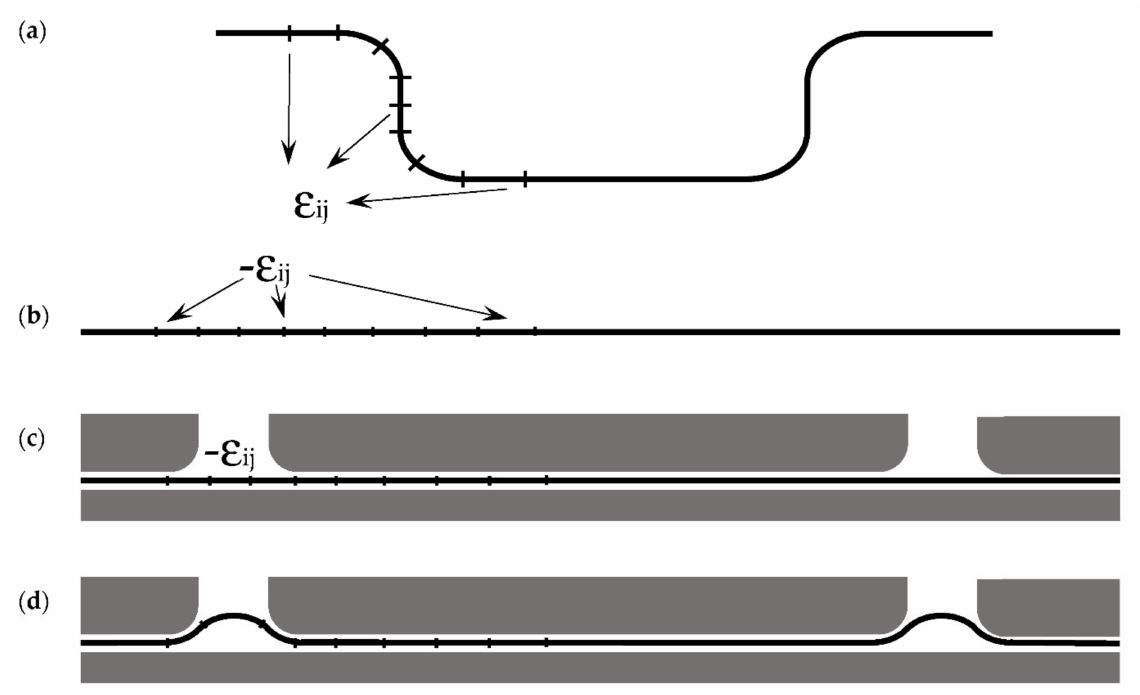
Figure 1. Schematic illustrating the steps of building a preforming shape: ( a )—simulation of forming under uniform pressure, ( b )—applying the obtained opposite sign field of strains to the initial flat blank, ( c )—placing the prestressed blank within the restraining shape, ( d )—identifying the preforming geometry by simulating the bulging process.